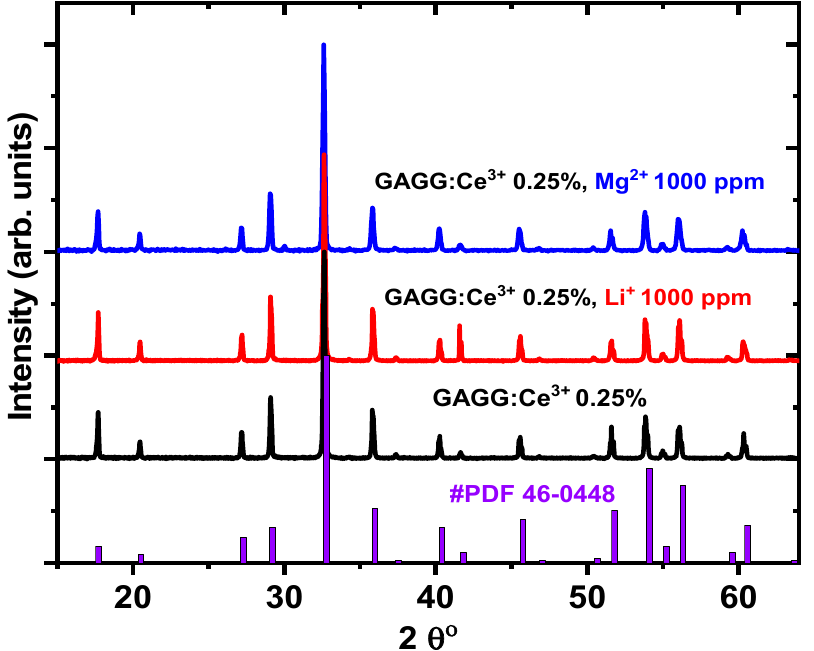
Figure 2. The powder XRD patterns for Li + and Mg 2+ co-doped GAGG:Ce 0.25% single crystals, 300 K.